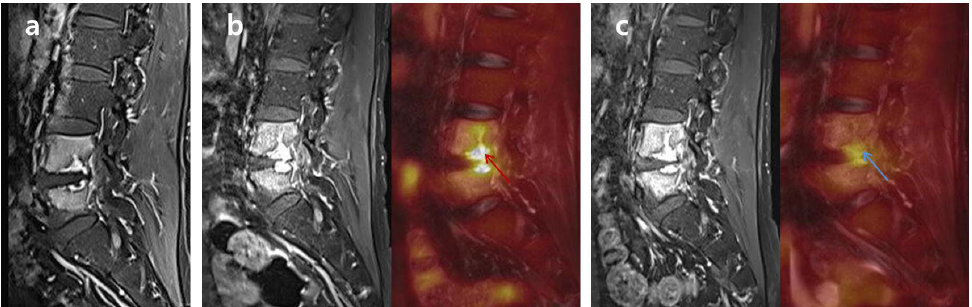
Figure 1. Differences in FDG uptake between ‘Non-cured’ and ‘Cured’ FDG-PET/MRIs. A 54-year-old male patient with lumbar PVO on L4-5 was treated with vancomycin and ciprobay for 46 days. The first clinical assessment on the 25th day of antibiotic therapy presented sustained back pain, intermittent fever, and a CRP/ESR of 1.399/64 (‘Non-cured’). Compared to the initial MRI ( a ) per- formed at the other hospital, the first FDG-PET/MRI ( b ) revealed an elevated FDG uptake (red arrow; SUV max 6.58) and progression of the PVO lesion. After additional antibiotic therapy, the patient showed improved back pain and no fever, with a CRP/ESR of 0.325/31 in the second